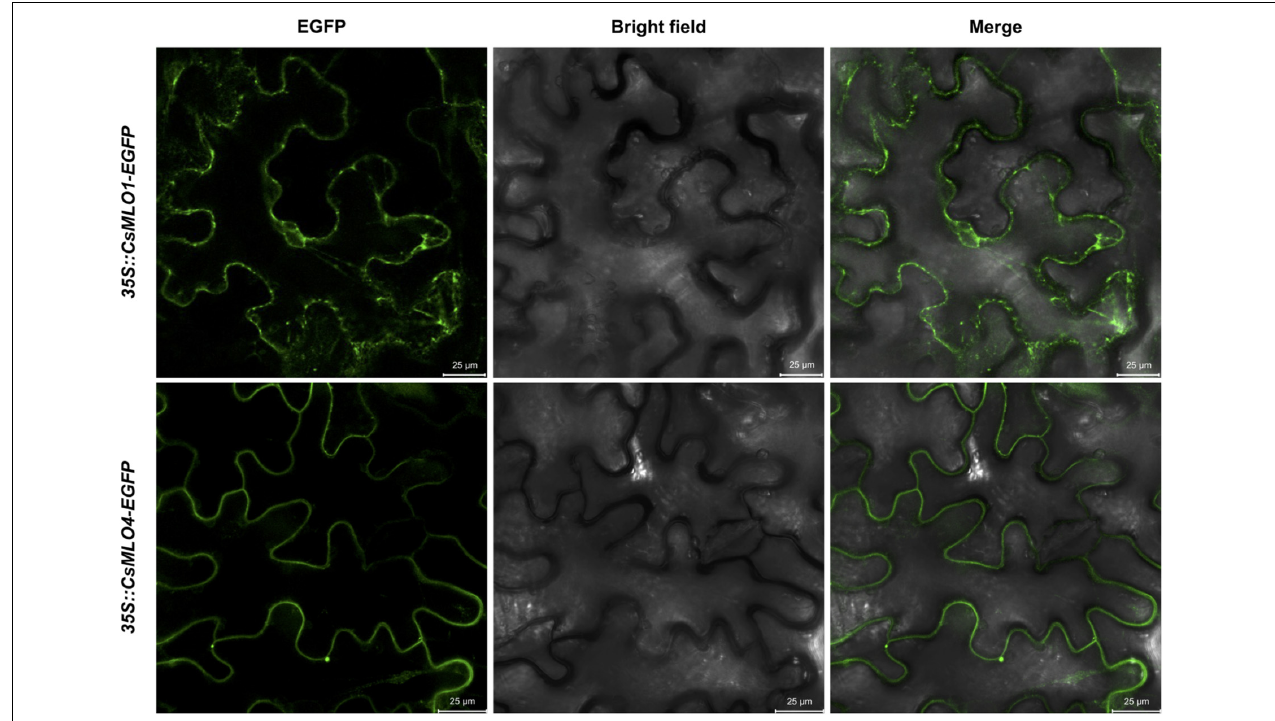
FIGURE 5 | Subcellular localization of CsMLO1 and CsMLO4 as observed by confocal laser scanning microscopy. Transient expression of 35S::CsMLO1-EGFP and 35S::CsMLO4-EGFP constructs in Nicotiana benthamiana leaf epidermal cells shown 3 days after agro-infiltration. Scale bars = 25 µ m.